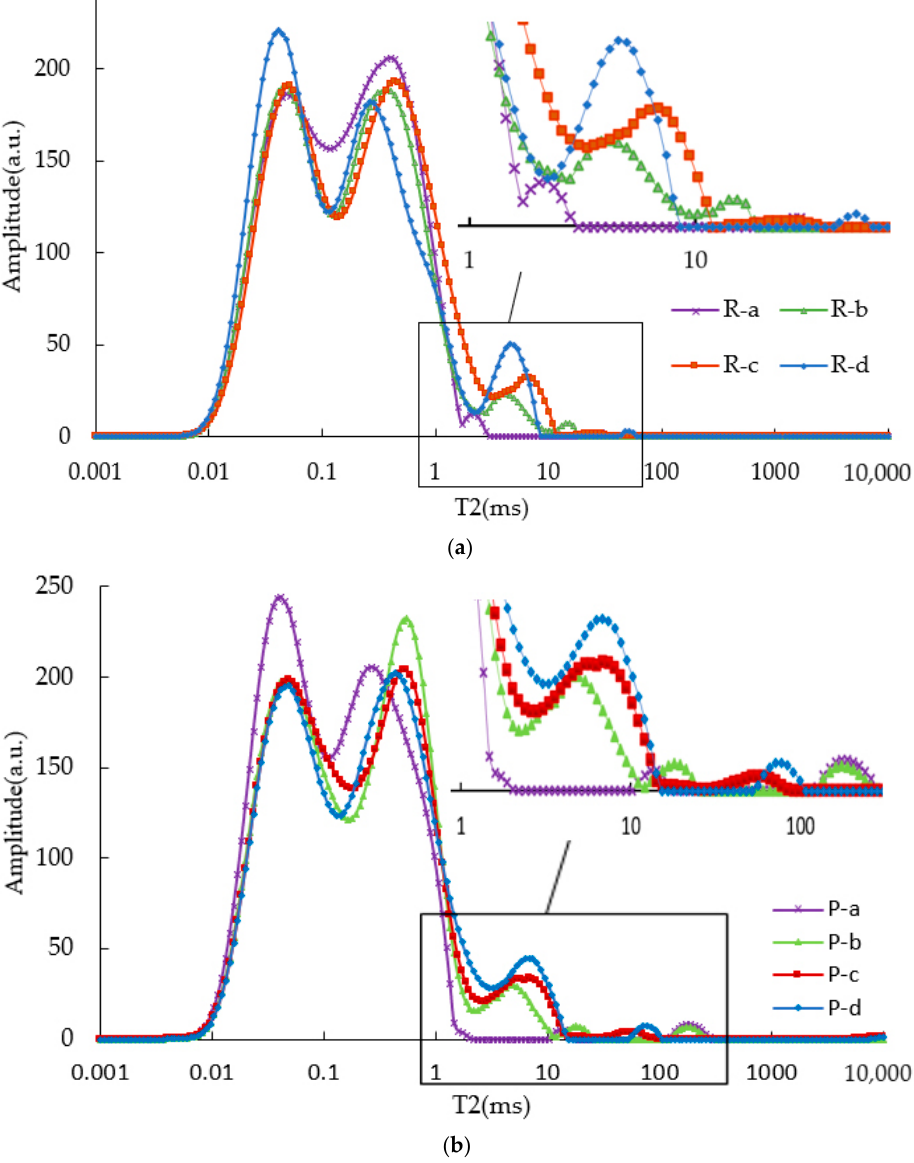
Figure 4. T2 of aged SBS asphalt binders. ( a ) T2 of RTFOT SBS asphalt binders; ( b ) T2 of PAV SBS asphalt binders.